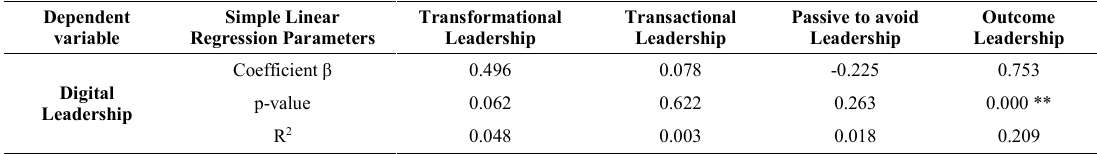
Table 10. Digital Leadership vs. Leadership Types.